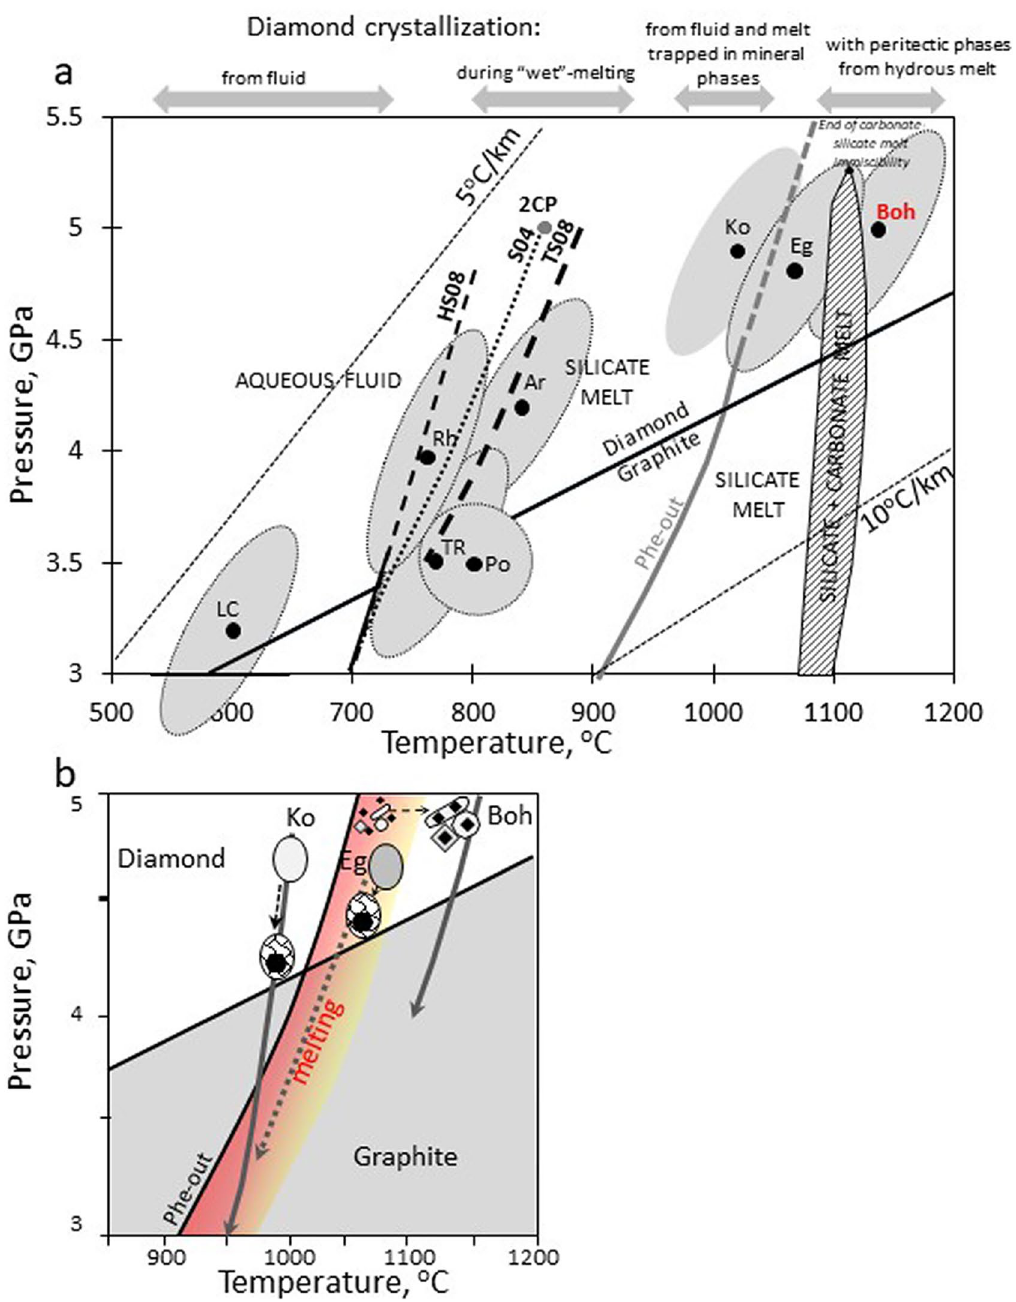
Figure 6. Mechanism of diamond crystallization in UHP terranes. ( a ) P–T peak conditions of diamond- bearing UHP terranes (see Table 2) relative to diamond-graphite transition 47 and melting reactions for crustal rocks. “Wet” solidus and second critical point (2CP) of pelites: solid line HS08 37 , stippled line S04 43 . Dashed line TS08 45 is wet solidus of carbonated pelites. Phe-out 37 marks phengite breakdown. Dashed field: miscibility gap between silicate and carbonate melts 44 . UHP rocks: low-T Lago di Cignana (LC) rocks; intermediate-T gneisses Tromso Nappe (TR) and Areskutan (Ar) in Scandinavian Caledonides, and Pohorie (Po) in the Eastern Alps; ultra-high-T Kokchetav (Ko) Massif in Kazakhstan, Erzgebirge (Eg) in Germany, and Bohemian (Boh) rocks from this study. Grey ellipses show the error bars of the peak P–T estimates (see references for the peak conditions in Table 2). ( b ) P–T paths of ultra-high-T diamond-bearing UHP rocks and diamond (full symbols) crystallisation mechanism. Red field: possible melting region. Kokchetav PT path 28 implies entrapment of fluid/ melt inclusions by host minerals and diamond crystallization upon the retrograde decompression and cooling: subsequent phengite-out melting in graphite stability field causes diamond graphitization in the melt. Erzgebirge PT path 29 suggests minor melt production on the prograde path due to phengite breakdown with insignificant diamond crystallization; more melting on retrograde path with entrapment of melt inclusions which crystallize diamond due to the decrease in carbon solubility upon decompression; no diamond graphitization on the retrograde path. Bohemian PT path 21 suggests phengite breakdown and melting on the prograde path resulting in co-crystallization of diamond and peritectic phases; retrograde evolution without diamond